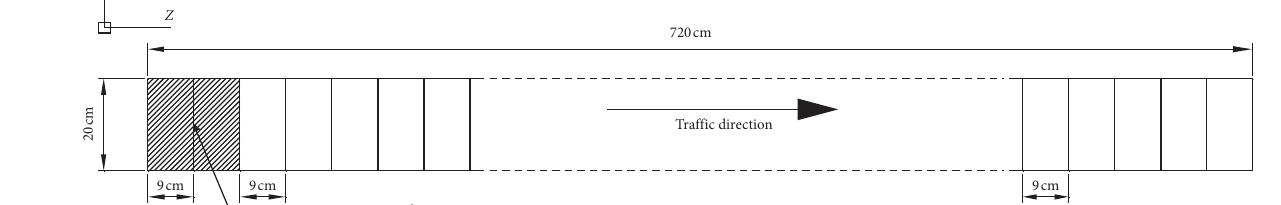
Figure 6: Schematic of moving loads.